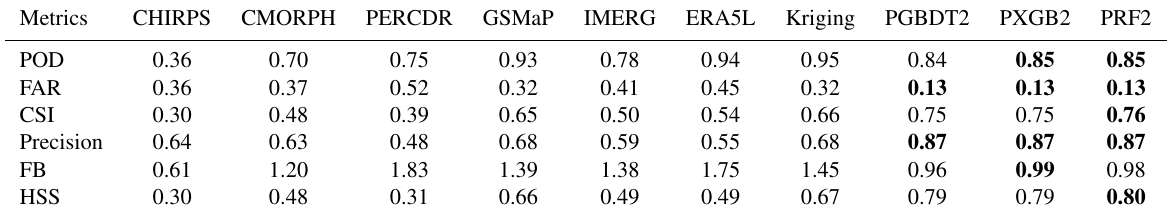
Table 3. The average value of categorical metrics of multiple products compared with gauge observations during the whole period. Metrics CHIRPS CMORPH PERCDR GSMaP IMERG ERA5L Kriging PGBDT2